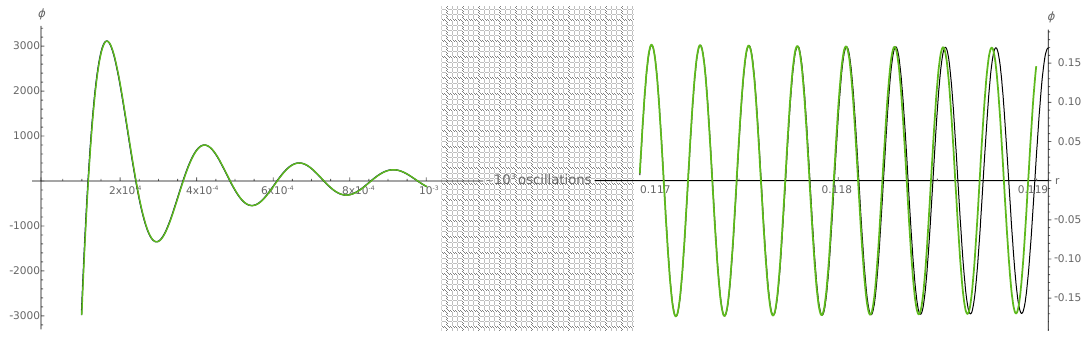
Figure 6 . Full non linear evolution (color) and approximate solution (black) for the scalar field profile φ at the beginning (right) and end (left) of the last relaxation epoch. The fit reproduces correctly the order thousand oscillations that lye in the middle. The parameters correspond to figure 1